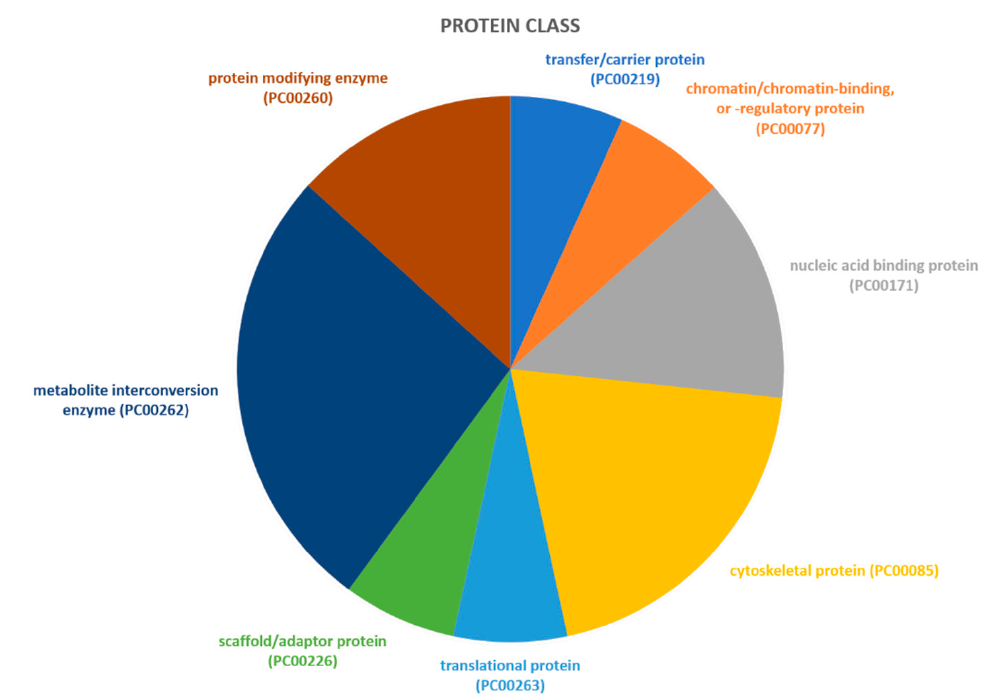
Figure 4. PANTHER classification of differently regulated proteins in RAOM in accordance to their protein class.